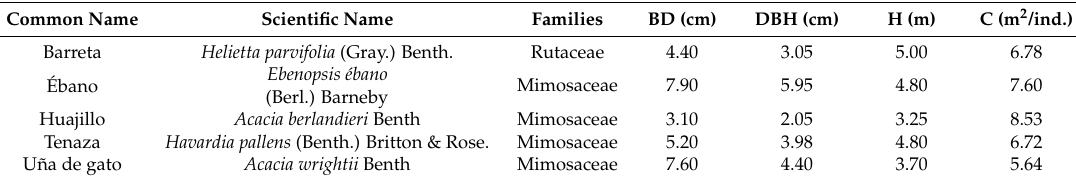
Table 1. Characteristics of sampled